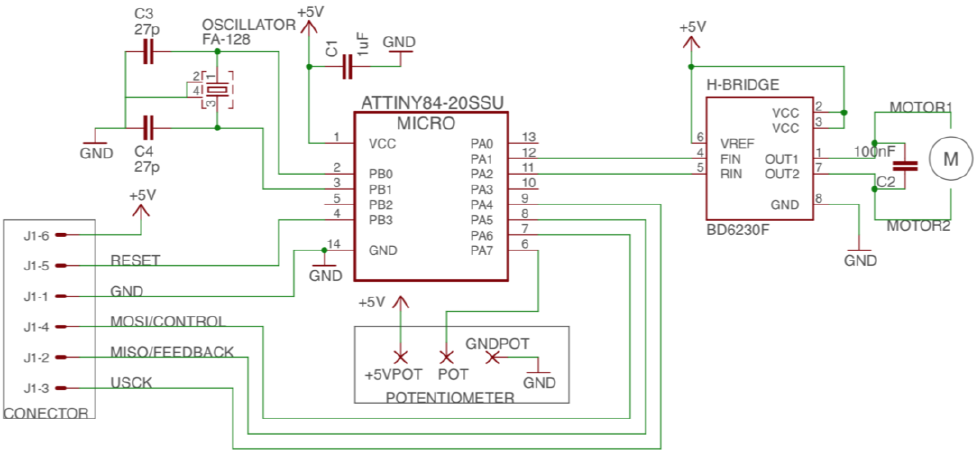
Figure 6. Schematic of the control circuit. J1 is the external connector that provides power supply and